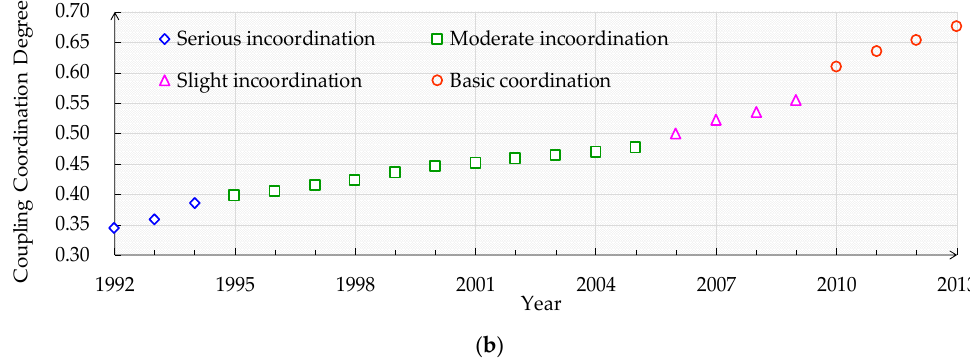
Figure 8. Spatio-temporal dynamics of coupling coordination level between urbanization quality and urban sprawl for the WTSUA from 1992 to 2013. ( a ) spatial variations of coupling coordination level between urbanization quality and urban sprawl for the WTSUA in different years; ( b ) change trend of CCD between urbanization quality and urban sprawl for the entire WTSUA from 1992 to 2013.